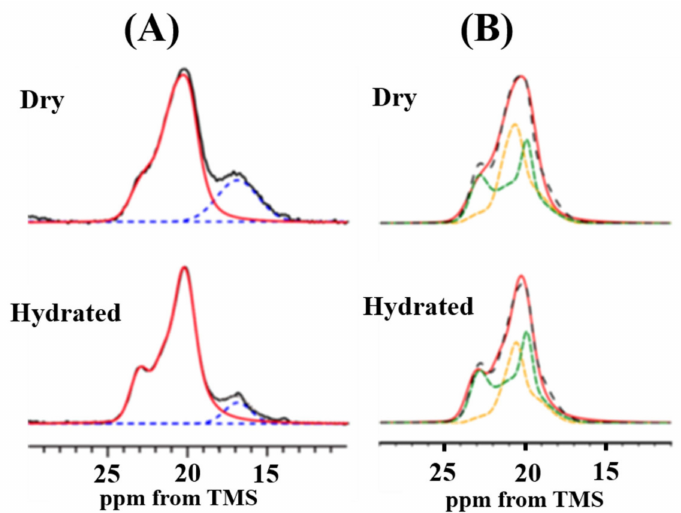
Figure 14. ( A ) Expanded Ala C β peaks in the 13 C CP / MAS spectra (10 − 30 ppm) of [3- 13 C]Ala- N. clavata dragline silk fibers in the dry and hydrated states together with peak deconvolution [59]. ( A ) The observed spectra (black solid lines) were deconvoluted by random coil (blue broken lines) and β -sheet structure (red solid lines). ( B ) The expanded Ala C β peaks with exclusively β -sheet structures were reproduced by superpositions (black broken lines) of the Ala C β peak patterns of (Ala) 6 (orange broken lines) and (Ala) 7 (green broken